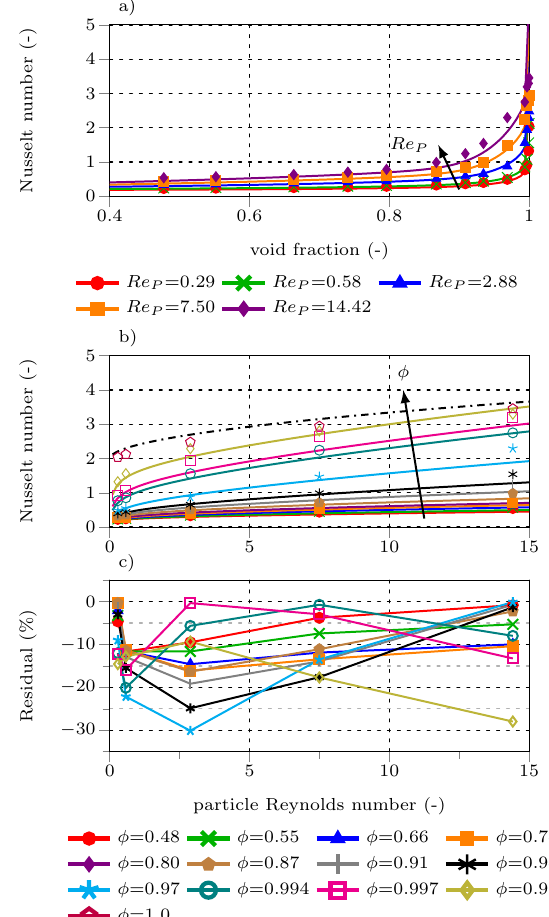
Figure 13. Comparison of Nusselt number calculated using Equations (17) and (20), x f = 2/3 and Equation (19) ( ) with values determined from simulations ( ) and Equation (5) ( ) versus the cluster void fraction ( a ) and particle Reynolds number ( b ). The relative errors of Equation (17) compared to CFD-simulated data is presented in ( c